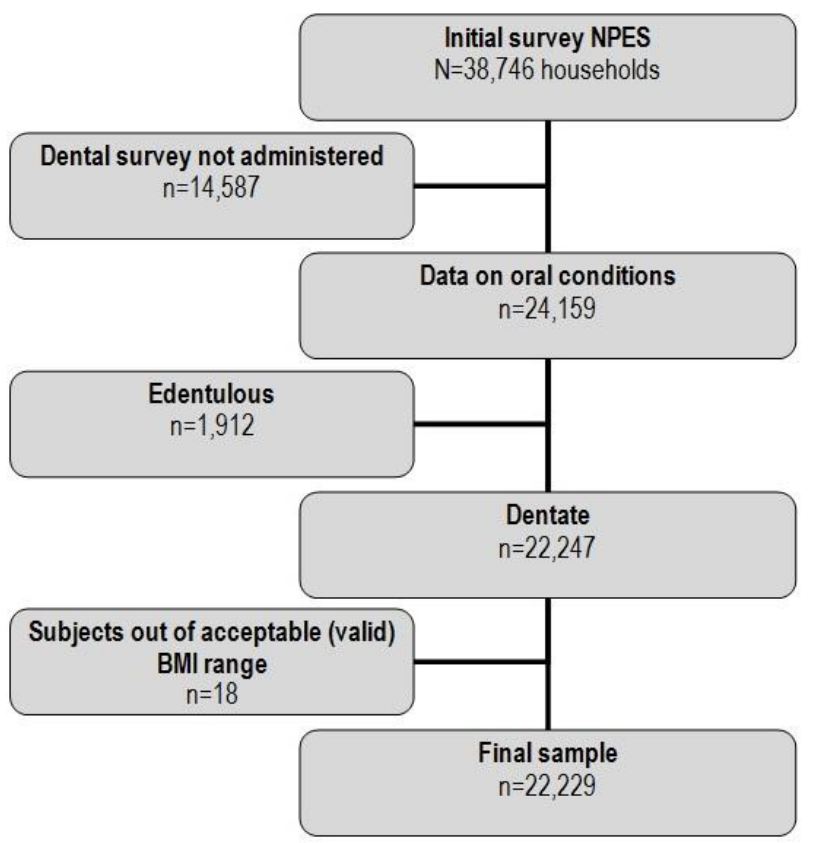
Figure 1. Flow chart for the individuals included in the